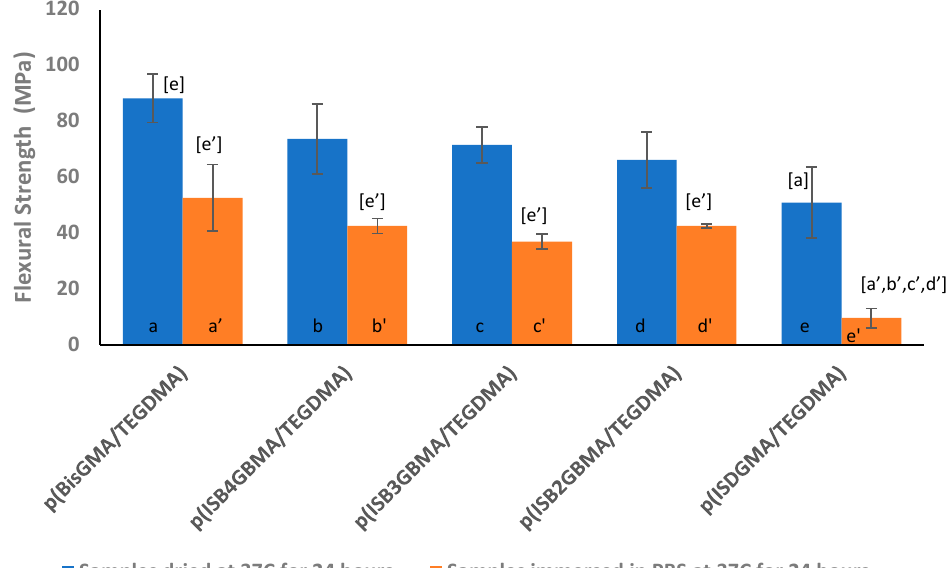
Samples immersed in PBS at 37C for 24 hours Figure 13. Flexural strength of p(BisGMA/TEGDMA), p(ISB4GBMA/TEGDMA), p(ISB3GBMA/TEGDMA), p(ISB2GBMA/TEGDMA), and p(ISDGMA/TEGDMA) at 60:40 wt% at RT. Letters indicate statistically significant difference ( p < 0.05) based on group.